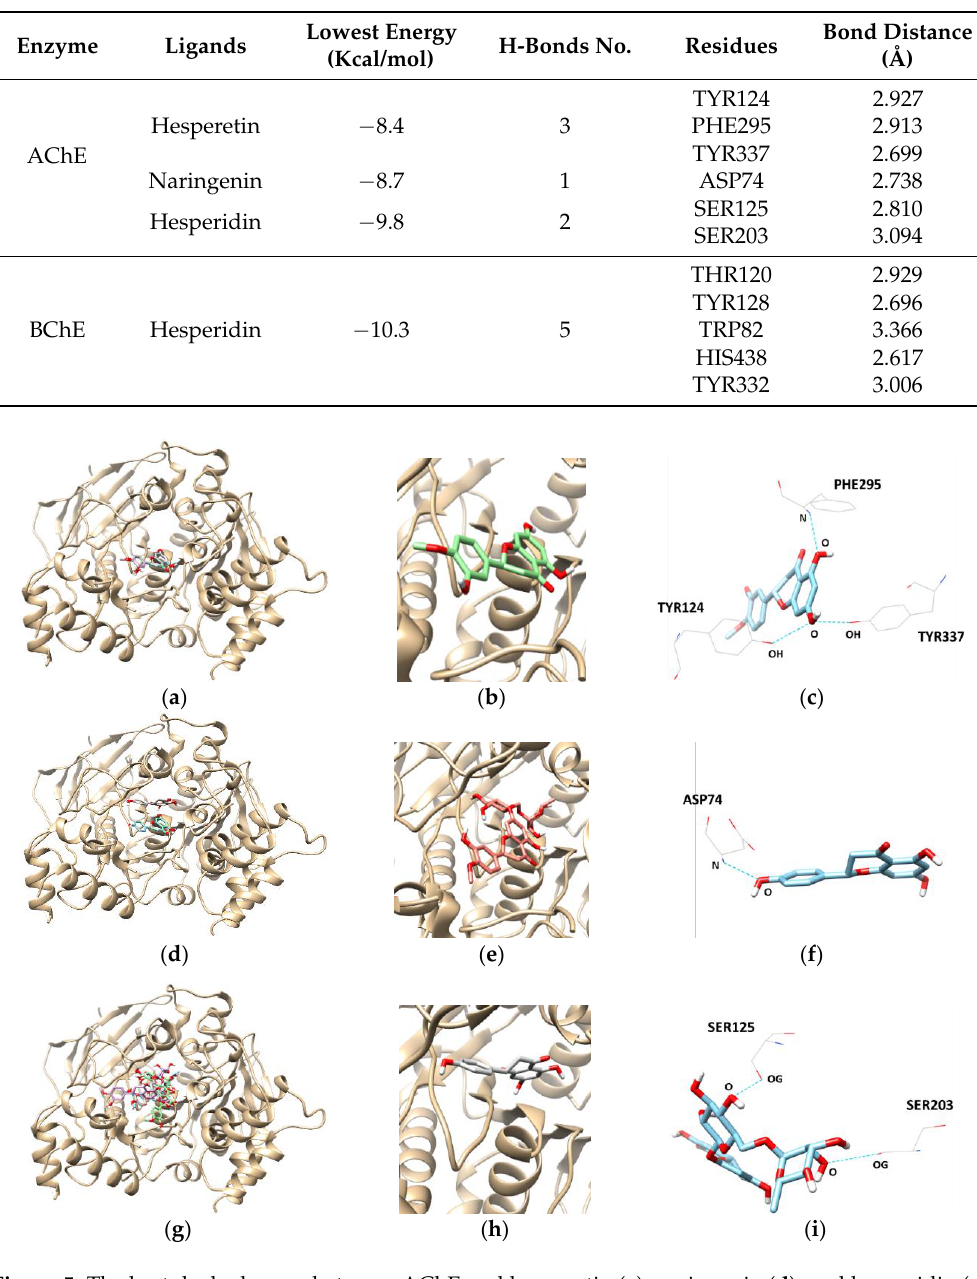
Figure 5. The best docked poses between AChE and hesperetin ( a ); naringenin ( d ); and hesperidin ( g ). View of the binding site magnified from hesperetin ( b ); naringenin ( e ); and hesperidin ( h ). Hydrogen interaction diagram of hesperetin ( c ); naringenin ( f ); and hesperidin ( i ). The blue dotted lines indicate hydrogen bonds between flavanones and AChE.